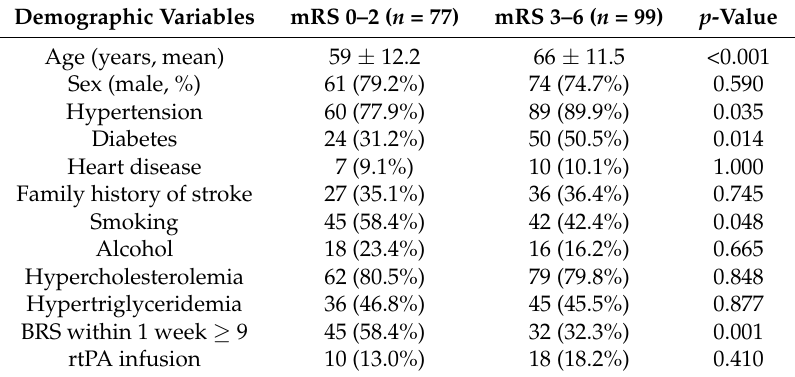
Table 3. Baseline characteristics of modified Rankin Scale groups at 1